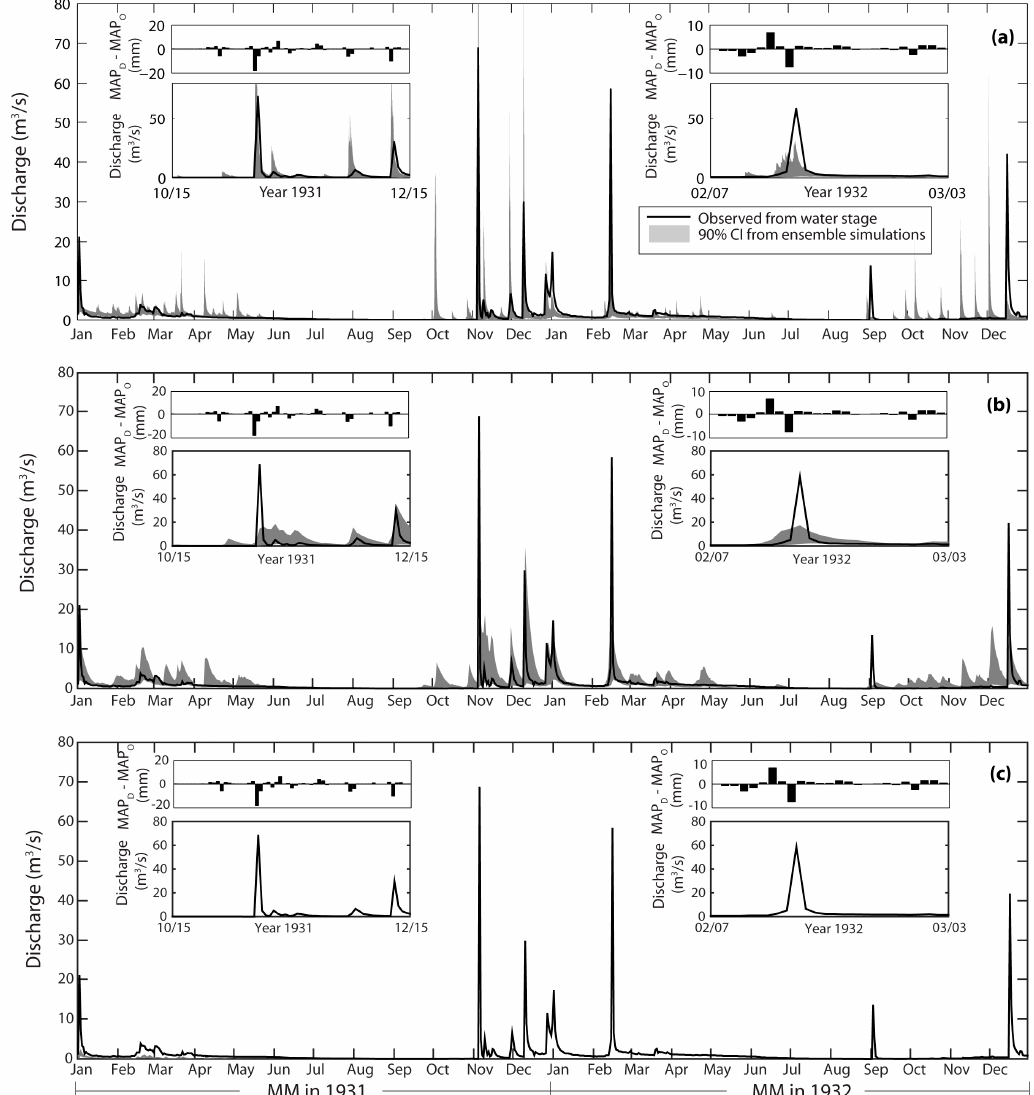
Figure 6. As Figure 4, simulations for the tRIBS ( a ), TOPKAPI ( b ), and CATHY ( c ) hydrologic models but for the 1931–1932 period (validation period for tRIBS).